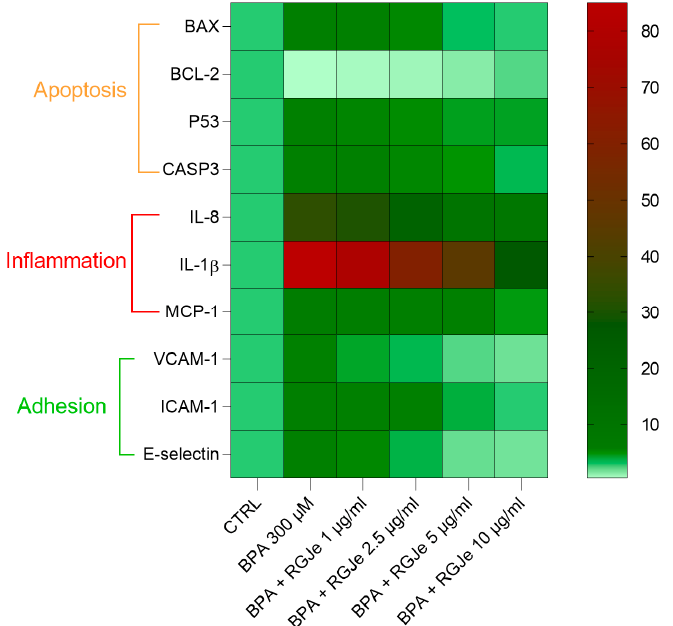
Figure 9. Heatmap of gene expression modulated by RGJe. The columns of the heatmap represent each treatment and the rows indicate the genes. Each cell is colored based on the amount of the gene found in that sample.